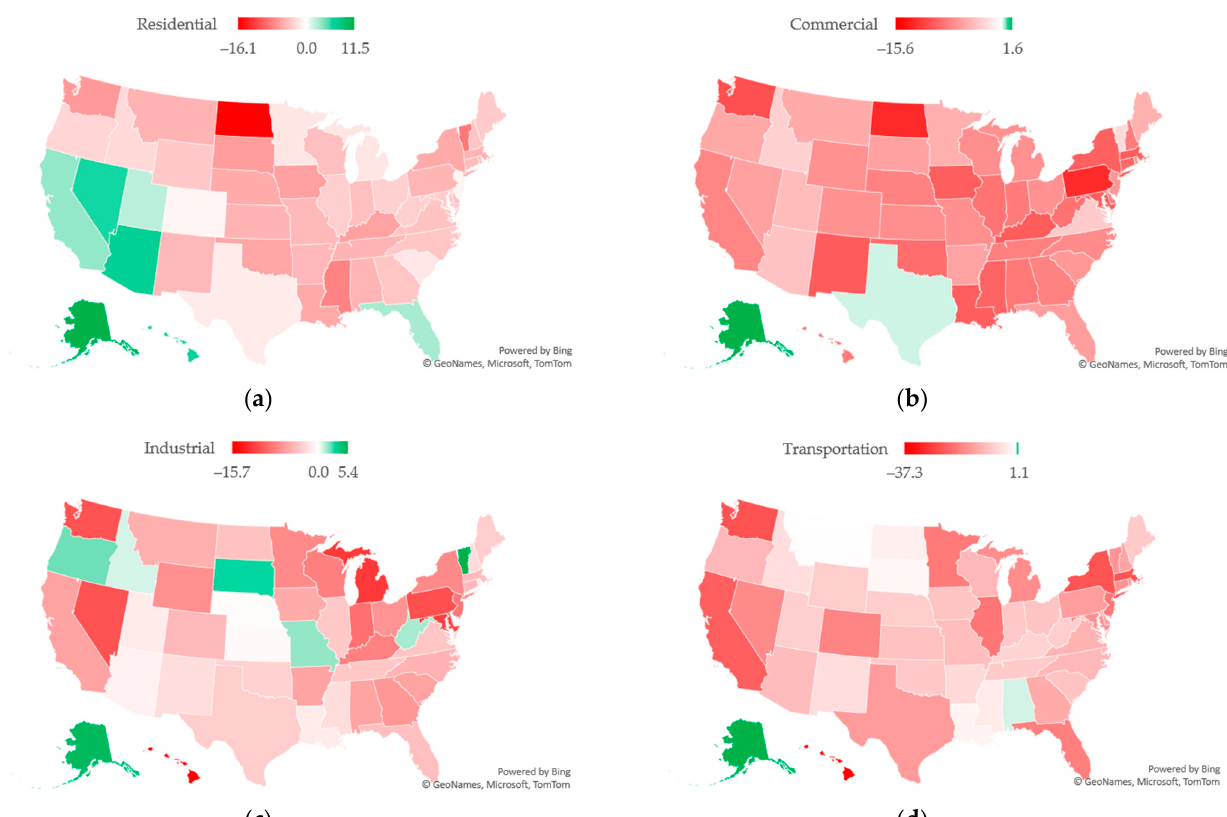
Figure 9. Change in 2020 sector energy consumption by state [30].